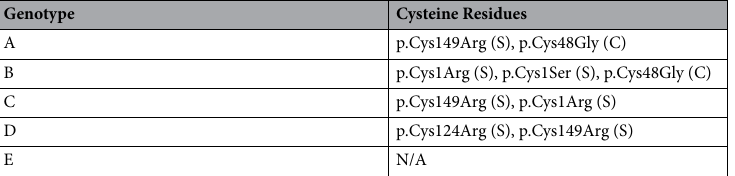
Table 1. Cysteine residues in genotypes A-E for common mutations between the clinical study and the literature with corresponding genes labelled in parentheses ( i.e., gene S, and gene C).